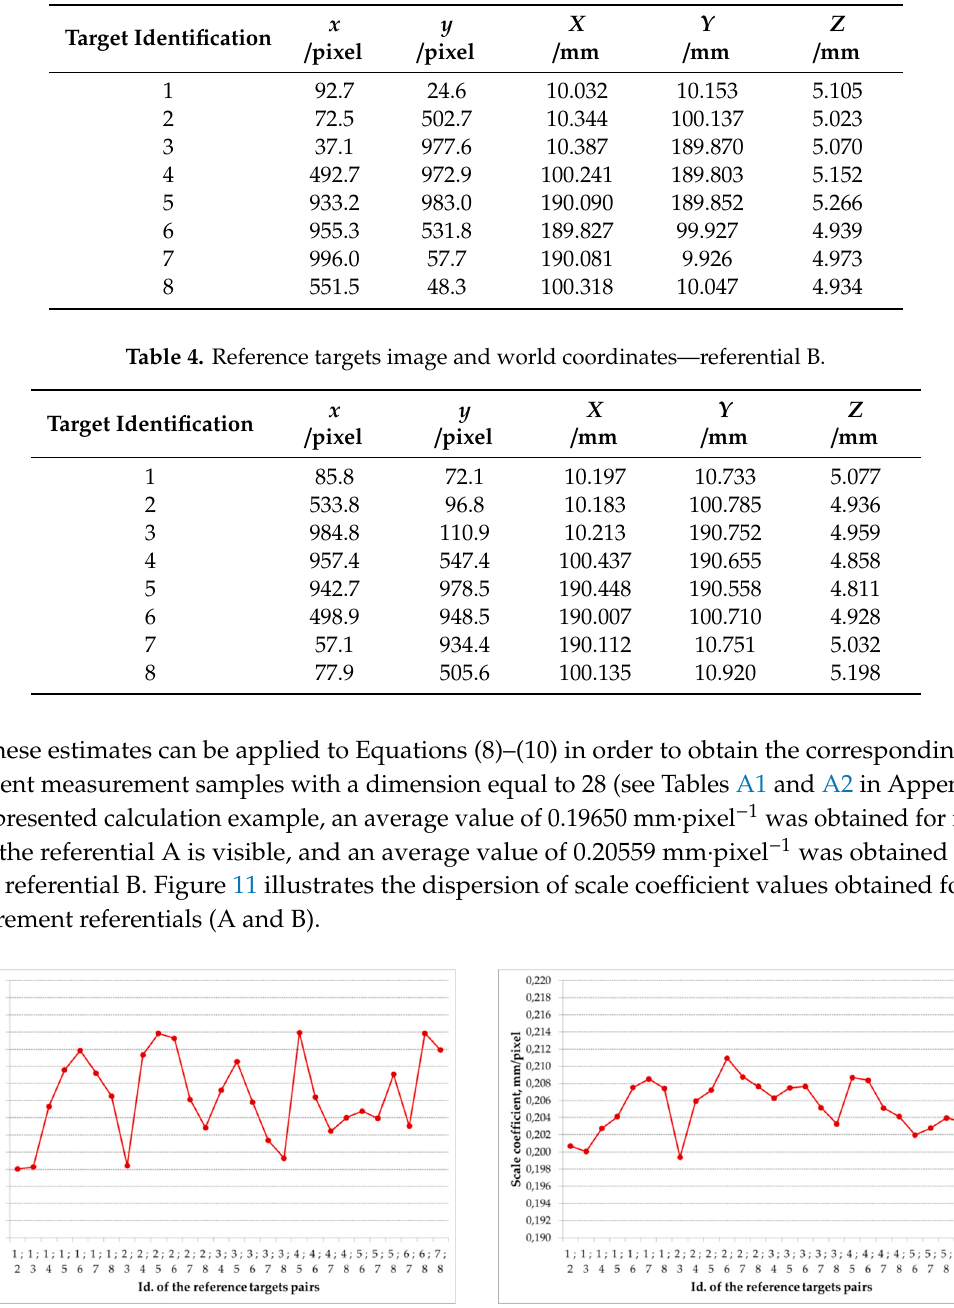
Table 3. Reference targets image and world coordinates—referential A.